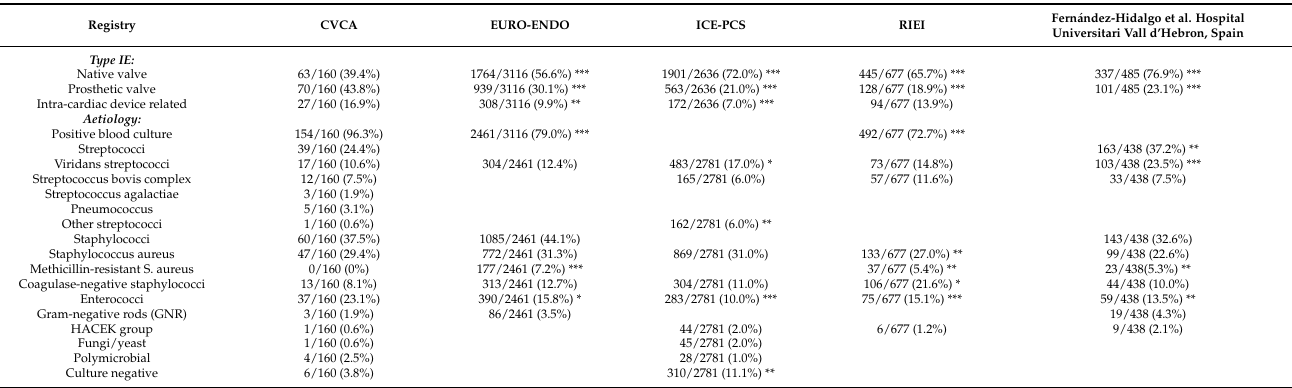
Table A3. Type and etiology of IE.